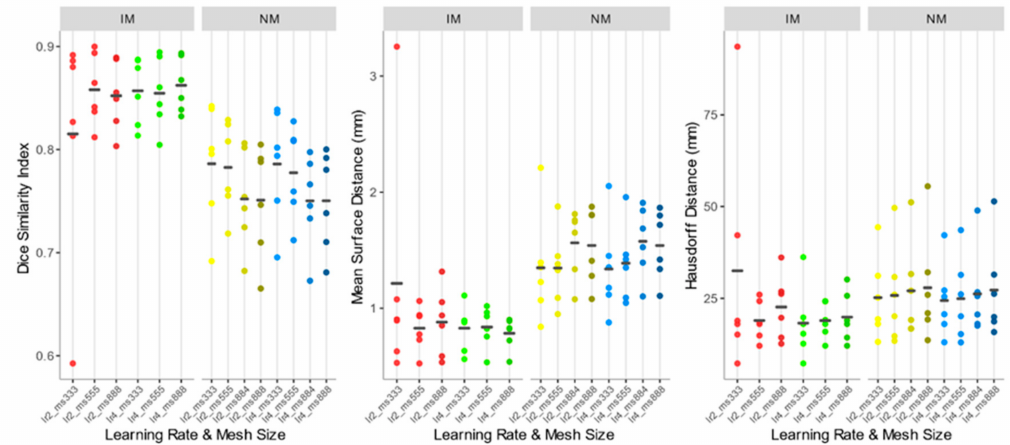
Figure 7. DSI, MSD, and HD values of the IM, NM elastic registration schemes. The accuracy indexes were evaluated considering the 4 muscle ROIs together.